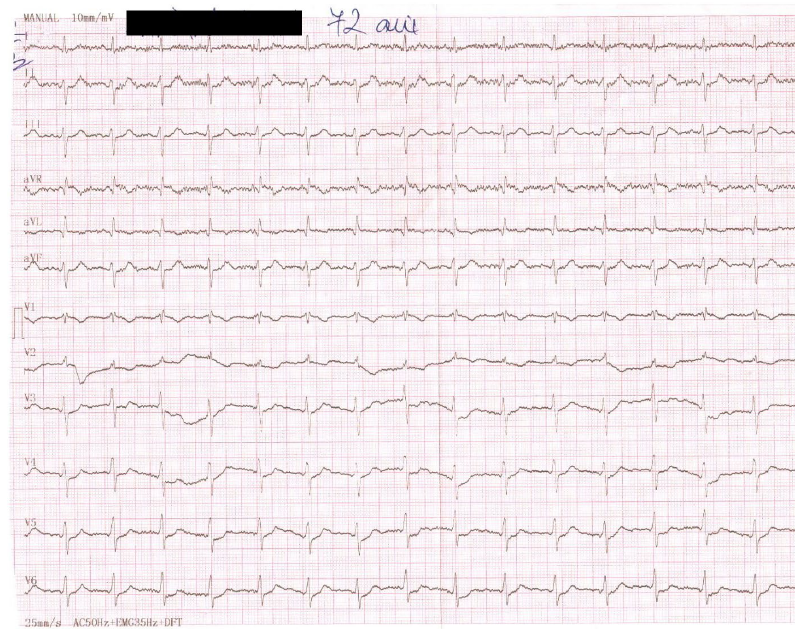
Figure 1. Admission electrocardiogram.